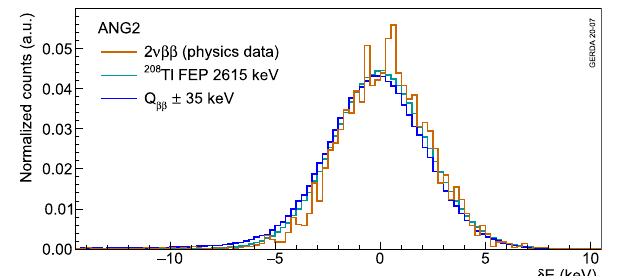
Fig. 19 Distribution of the δ E classifier for calibration events in the 208 Tl FEP and in the Compton region around Q ββ as well as for physics eventsinthe2 νββ regionforthecoaxialANG2detector.Thehistograms are normalized to their integrals